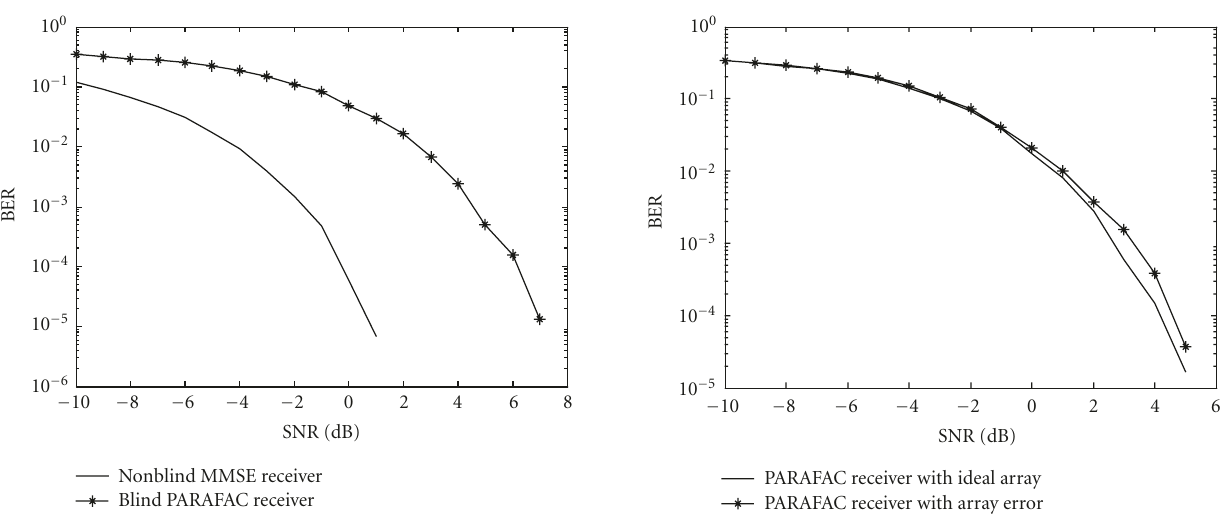
of blind PARAFAC signal detection algorithm for polariza- tion sensitive array is close to nonblind MMSE method, and this algorithm works well in array error condition and sup- ports small sample